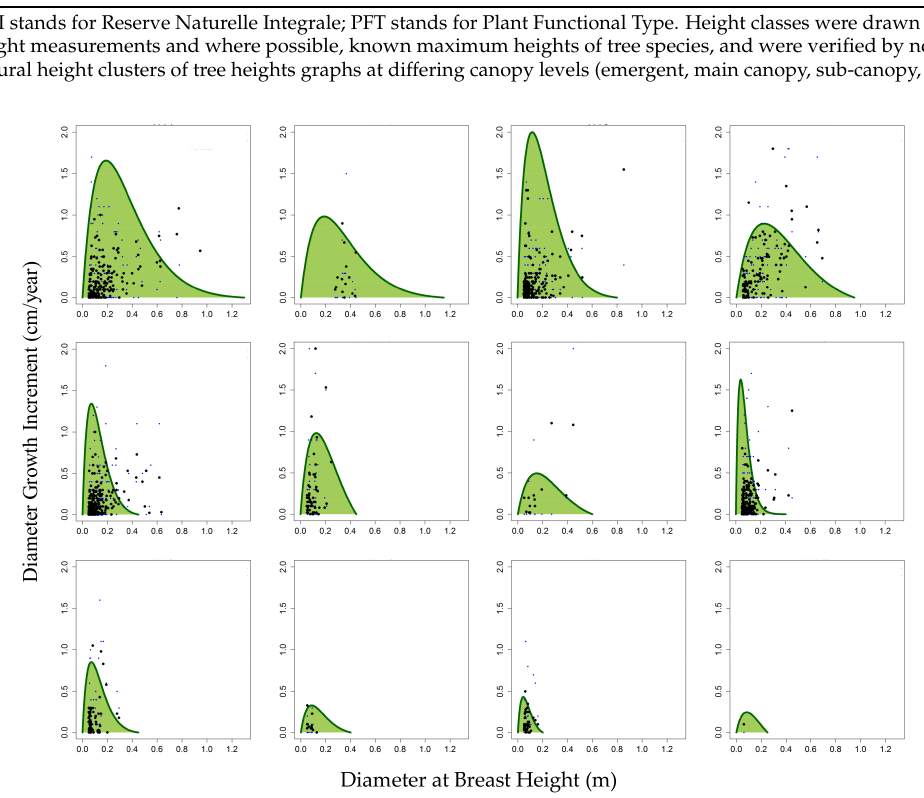
Figure 2. Maximum growth curve comparison among species groups for Betampona (BTP) 2004–2005 (blue points); 2004–2008 (black points). The points represent individual trees within each plant functional type during the year corresponding to the dot color. Growth curves were fit to each plant functional type (in green), the equations of which were the growth functions used in the model parameterization. PFT: Plant Functional Type. Top row from left to right: PFT 1, PFT 2, PFT 3, and PFT 4. Middle row from left to right: PFT 5, PFT 6, PFT 7, and PFT 8. Bottom row from left to right: PFT 9, PFT 10, PFT 11, and PFT